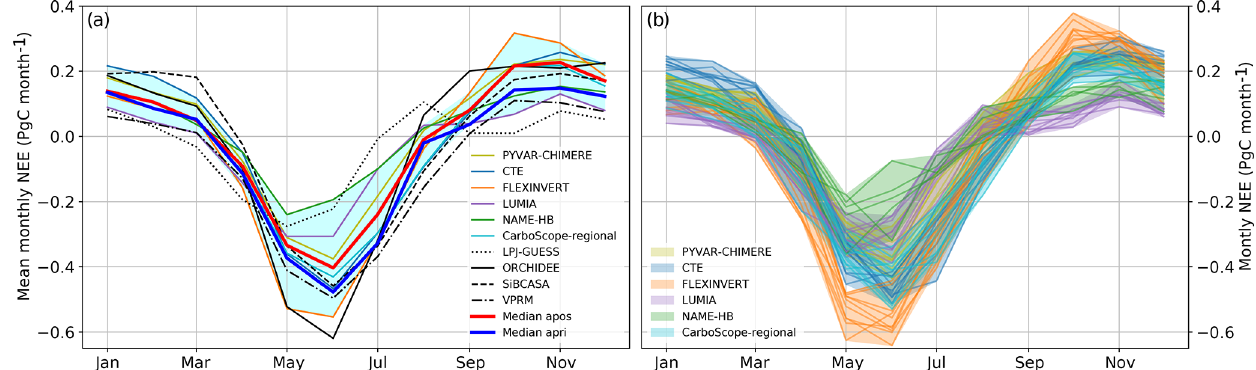
Figure 7. (a) Average seasonal cycles of the prior and posterior estimates. The prior and posterior ensemble median are represented as thick solid lines, and the spread of the posterior ensemble is shown as a shaded area. (b) Variability of the seasonal cycle during the 10 years of the inversion (the shaded areas represent the range of monthly NEE and the solid lines correspond to the individual